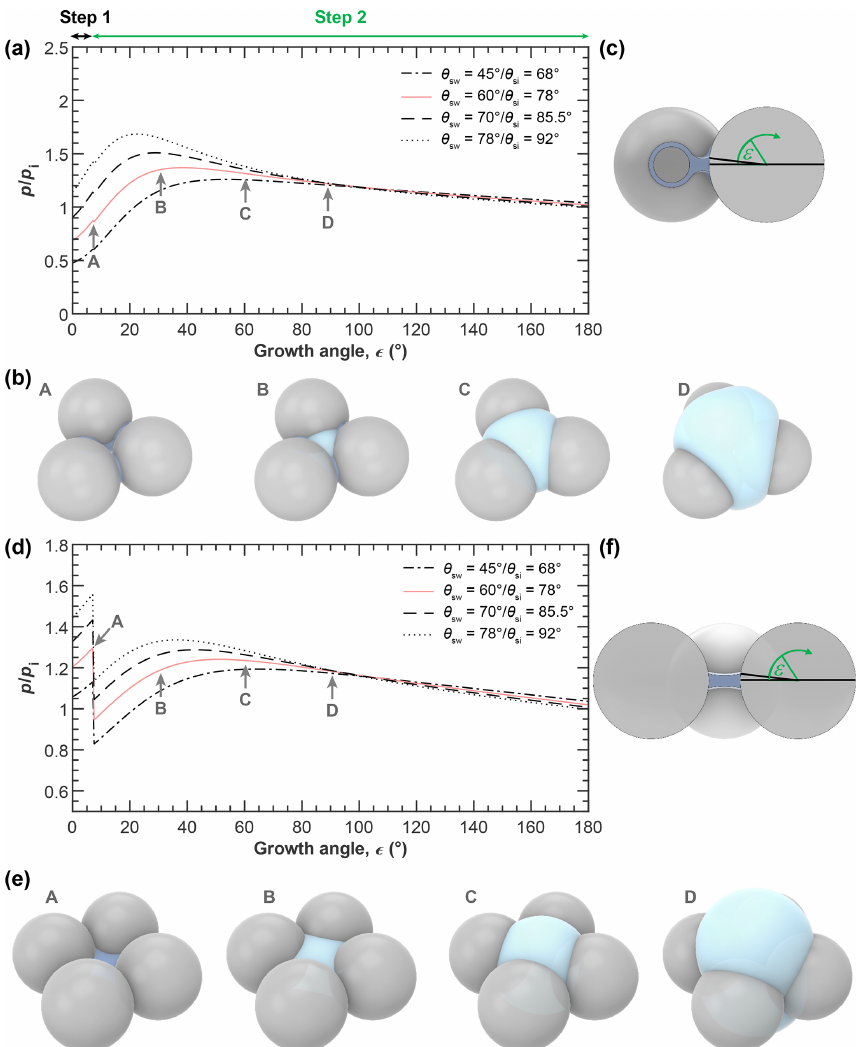
Figure 6. PCF by three-membered (a–c) and four-membered (d–f) ring pores. (a, d) Saturation ratio with respect to ice ( p/p i = S i ) required for (step 1) direct filling of the ring pore up to a filling level h fl = h fr = 1 . 25nm, followed by (step 2) growth of pore ice as a function of the growth angle ε , as illustrated in the side views (panels c and f ). The 3D renderings illustrate the water growth up to h fr = 1 . 25nm (A: darker blue; ε is 7 . 18 ◦ ) and ice growth (light blue; ε is 30 ◦ (B), 60 ◦ (C), and 90 ◦ (D)) for a three-membered ring pore with D pp = 20nm, C ov = 0 . 05, and θ sw (θ si ) = 60 ◦ (78 ◦ , panel b ) and a four-membered ring pore with D pp = 20nm, C ov = 0 . 1, and θ sw (θ si ) = 60 ◦ (78 ◦ , panel e ). All soot-PCF curves were calculated for T = 220K, D pp = 20nm, and different contact angles as indicated in the legend. See Figs. D1 and D2 for soot-PCF curves encompassing different primary particle sizes and overlap